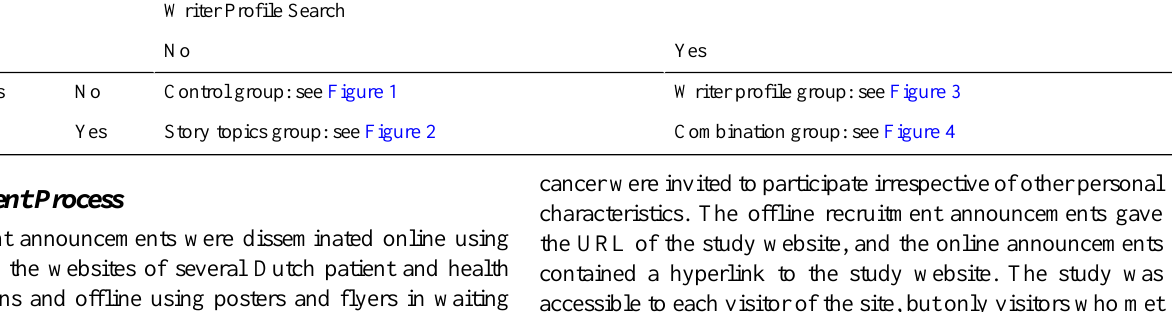
Table 1. The 2x2 factorial design of the study Writer Profile Search